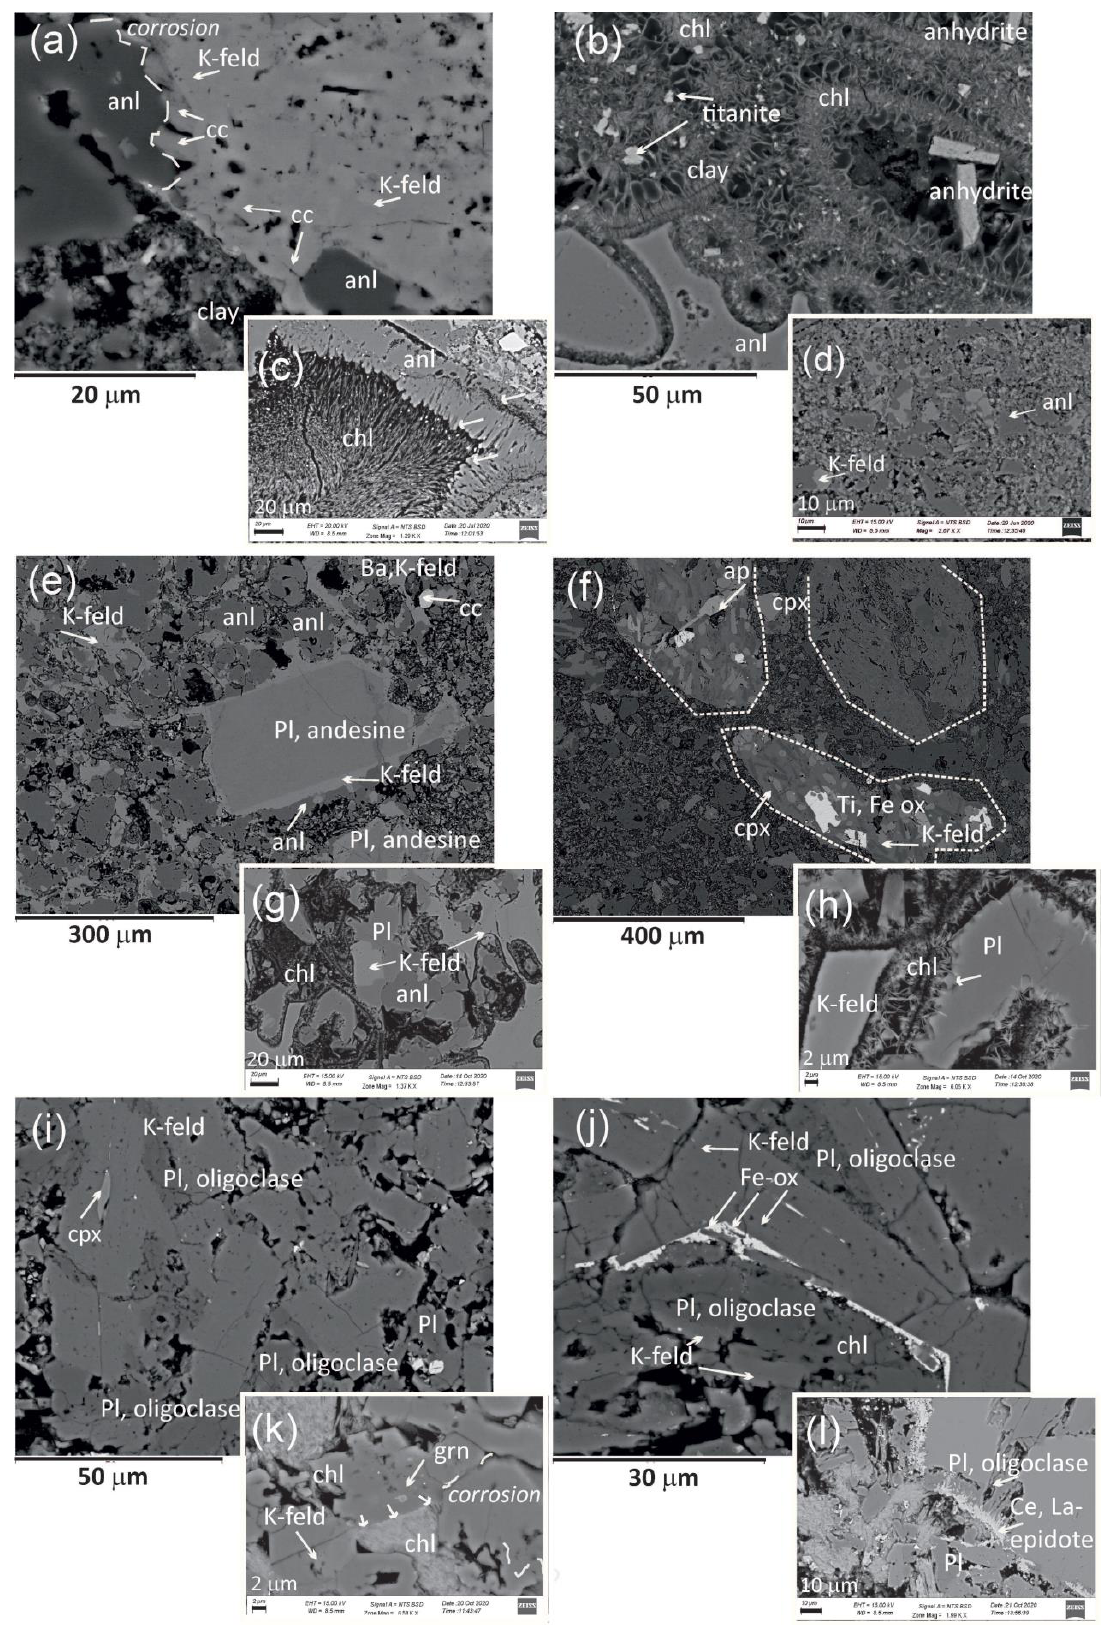
Figure 6. The reservoir rocks cored at the San Vito 1 borehole under the electron microscope. ( a – d ) The yellow tuff cored at 804 m of depth from the argillic facies, ( e – h ) the chaotic tuffs cored at depths of 1412 m from the phyllic facies and ( h , i ) the